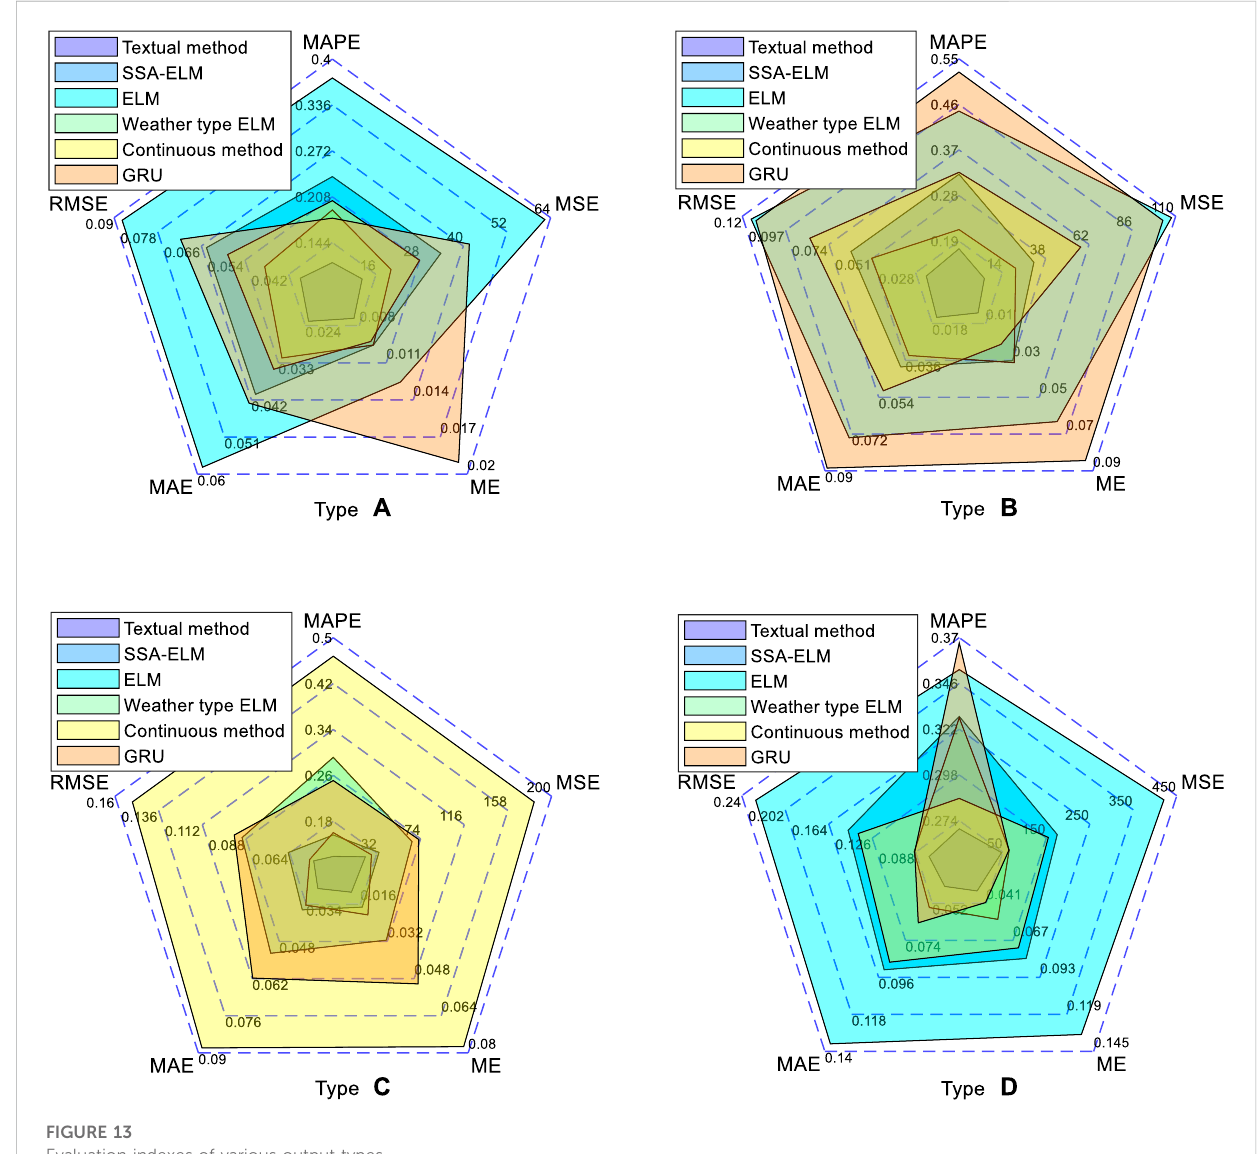
FIGURE 13 Evaluation indexes of various output